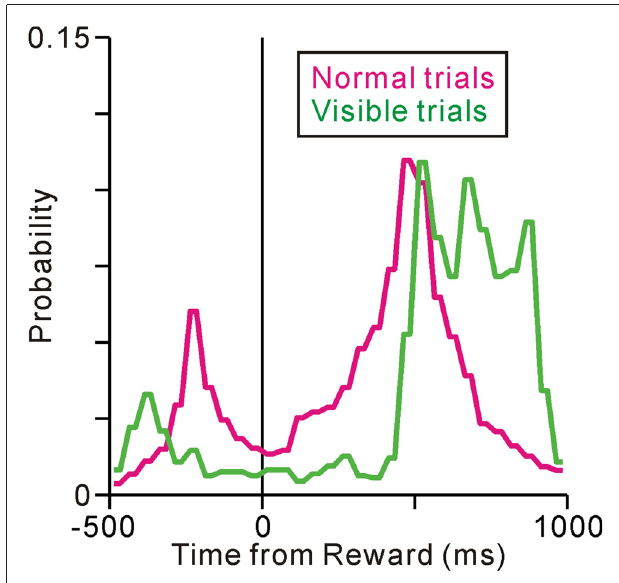
FIGURE 3 | Histograms for the fixation break times under the normal (magenta) and visible (green) task